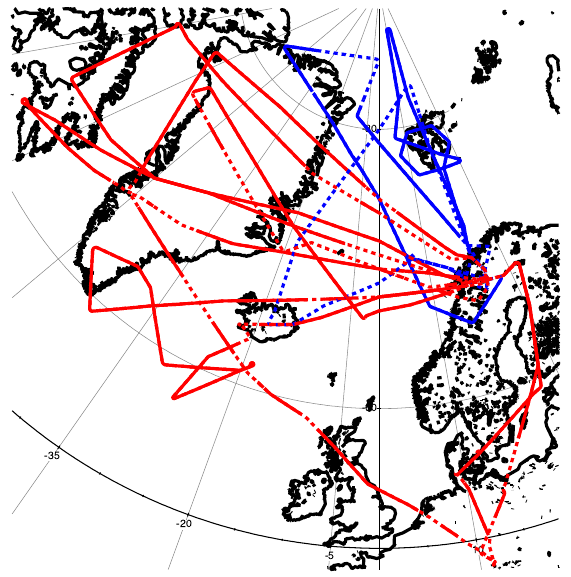
Figure 2. Flight tracks during the POLSTRACC campaign. Blue colours indicate flights during phase 1 (12 January–2 February), red colours indicate flights during phase 2 (26 February–18 March). Flights that were used for the analysis are shown as solid lines. Dotted lines denote flight legs with PV < 7PVU. For details see Sect.